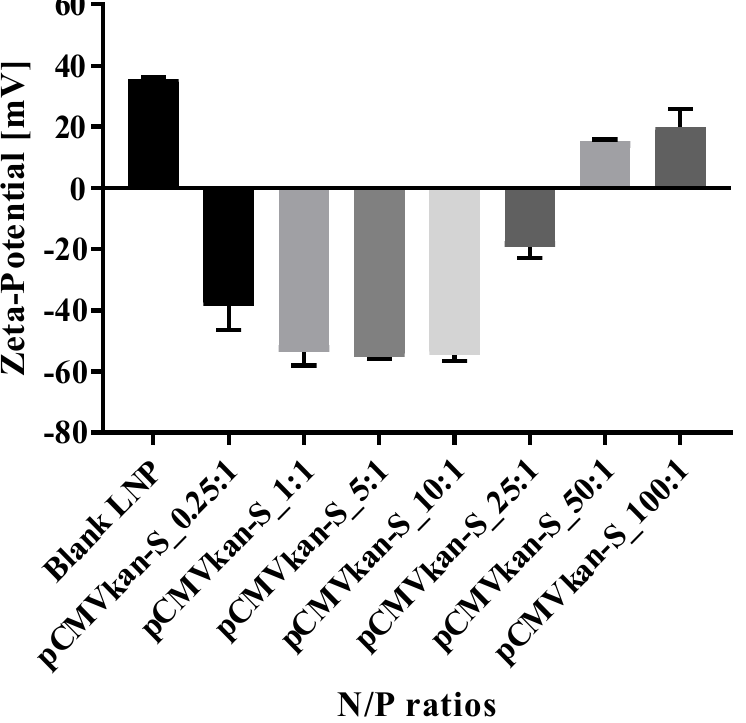
Figure 6. Zeta-potential results for DOTAP4/pCMVkan-S complexes at different N/P ratios ( n = 6). Results are compared to blank liposome size profile. Lipoplex data were measured 30 min after liposome-DNA complexation at various N/P ratios.